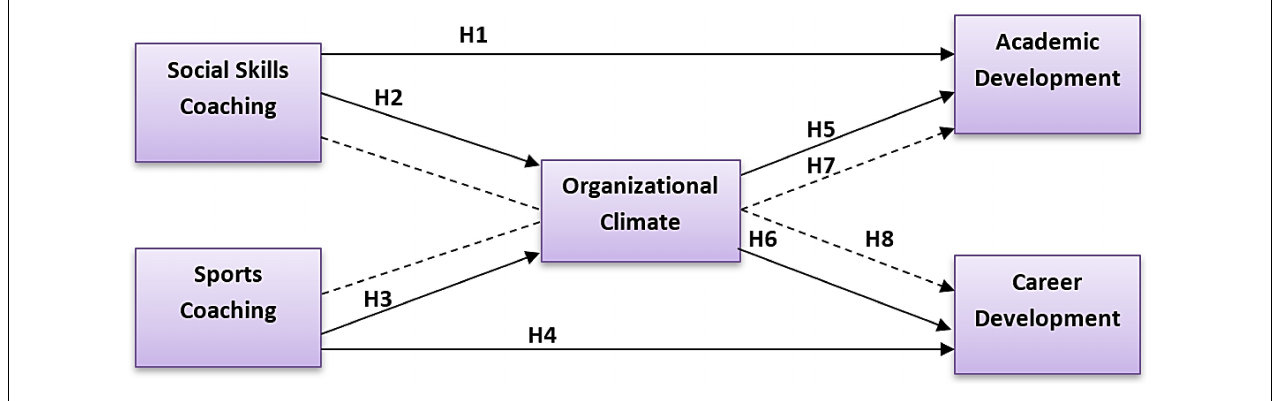
FIGURE 1 | Conceptual